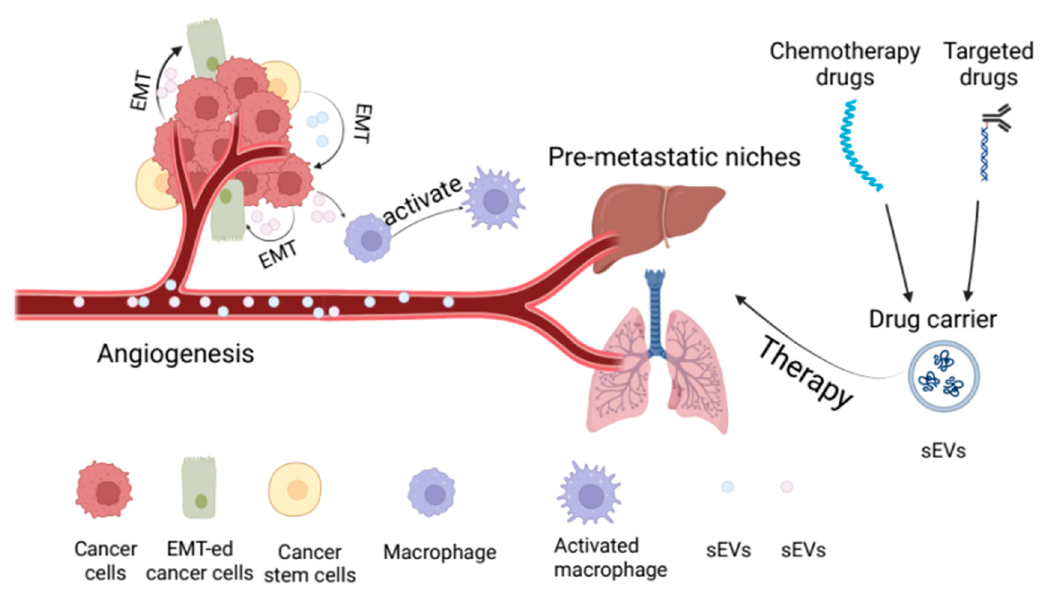
Figure 2. The general function of sEV in tumors and its use in therapy. This figure summarizes the role of sEVs in urological tumors and their application in the treatment. Urological tumor cells and sEVs released by urological cancer stem cells can promote tumor cell EMT, endothelial cell angio- genesis, macrophage activation, and pre-metastatic niches formation. sEVs can be used as drug de- livery systems to treat urological tumors. (This figure was created with